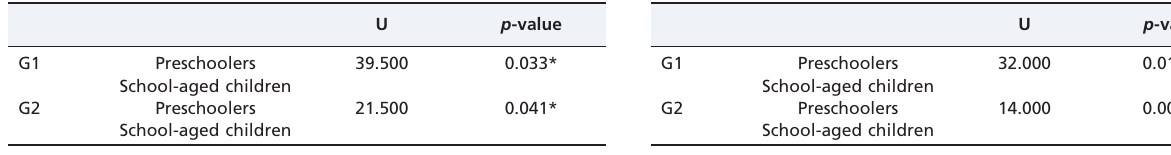
Table 3 - Comparisons by age group for the CV syllable duration.